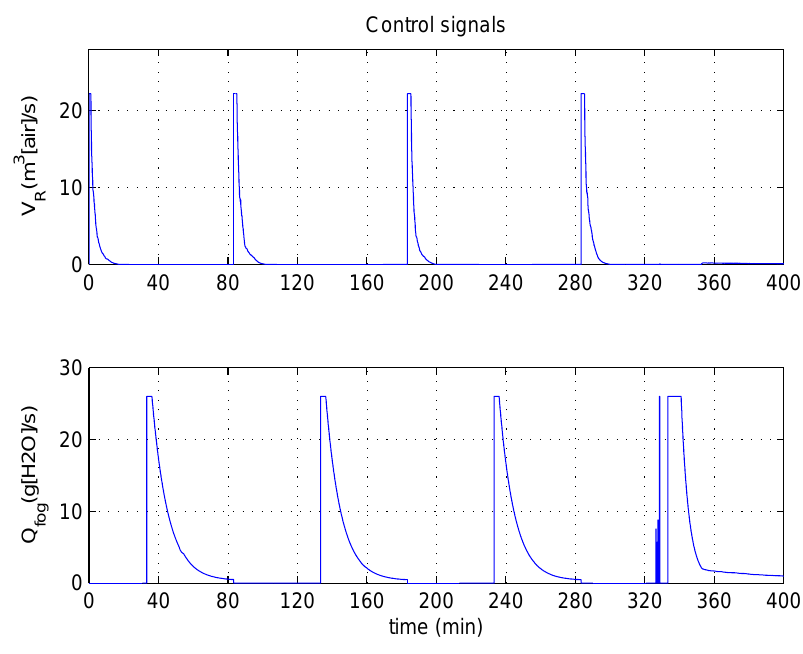
Figure 8. Variation of Neuro-PID control signals during the tuning